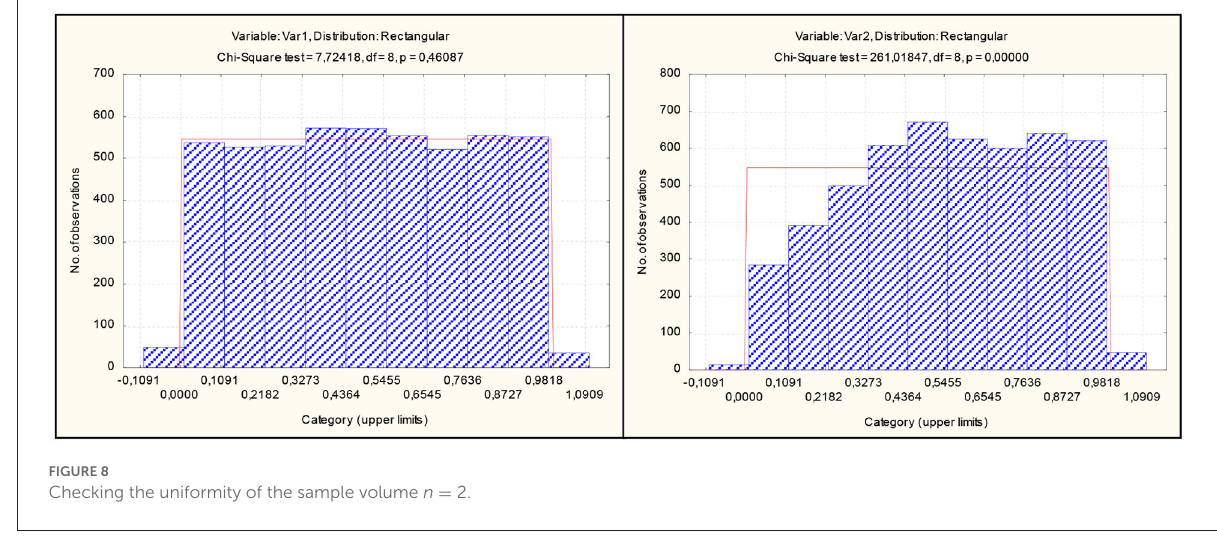
TABLE 1 Achieved p-levels of the hypothesis H 0 relatively to H 1